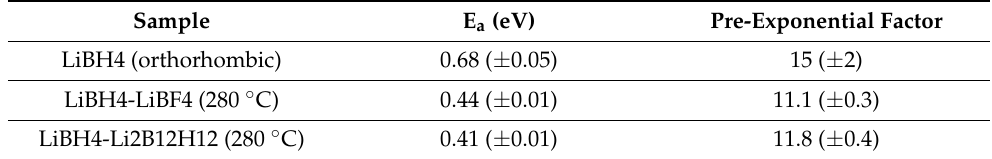
Table 1. Activation energies (eV) calculated from a linear plot of ln( σ T) and 1000/T of the EIS data reported in Figure 3c. The standard deviation is based on the 99% confidence interval of the linear fit.